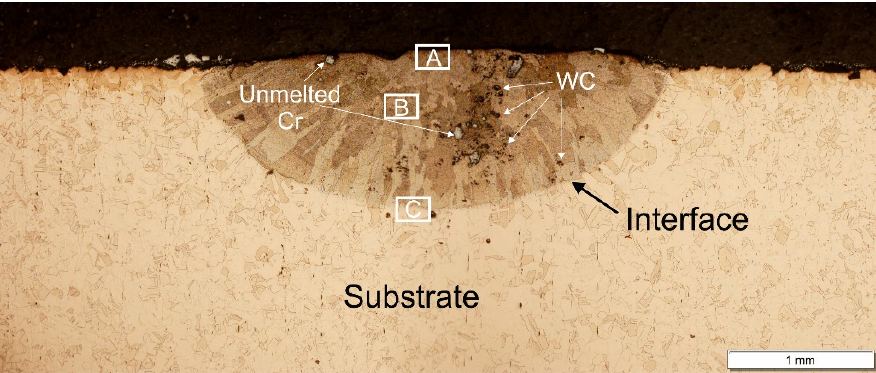
Figure 3. Macrostructure of the laser-alloyed surface layer Cr75WC25, single track. Microstructure of the Cu after laser alloying with different percentage contents of Cr and WC is shown in Figure 4 in the upper area of the alloyed zone (area A in Figure 3), the middle (area B in Figure 3) and on the interface surface layer and substrate (area C in Figure 3). As seen in Figure 4, the microstructure consists mostly of fine grains with a few